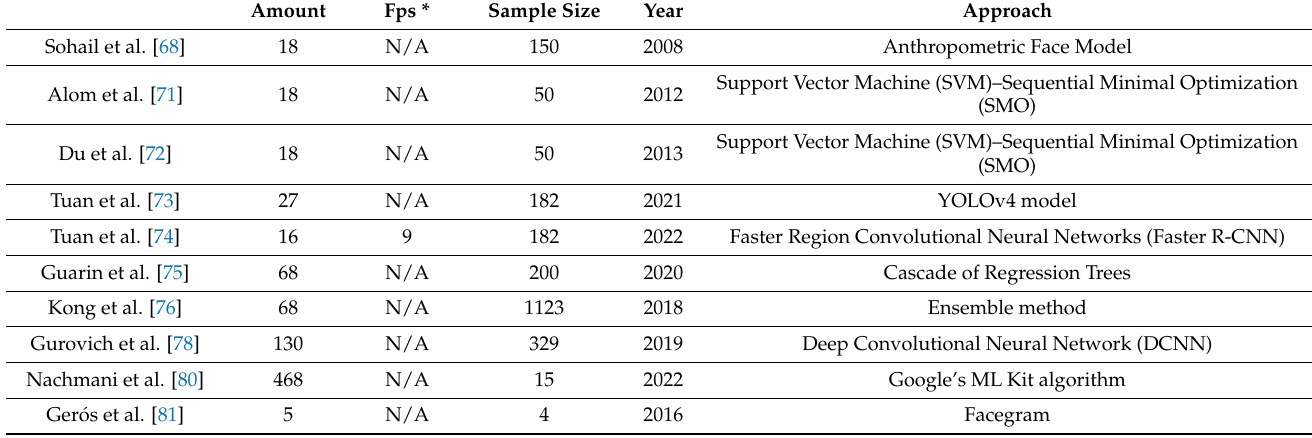
Table 3. Summarizing the facial landmark extraction in